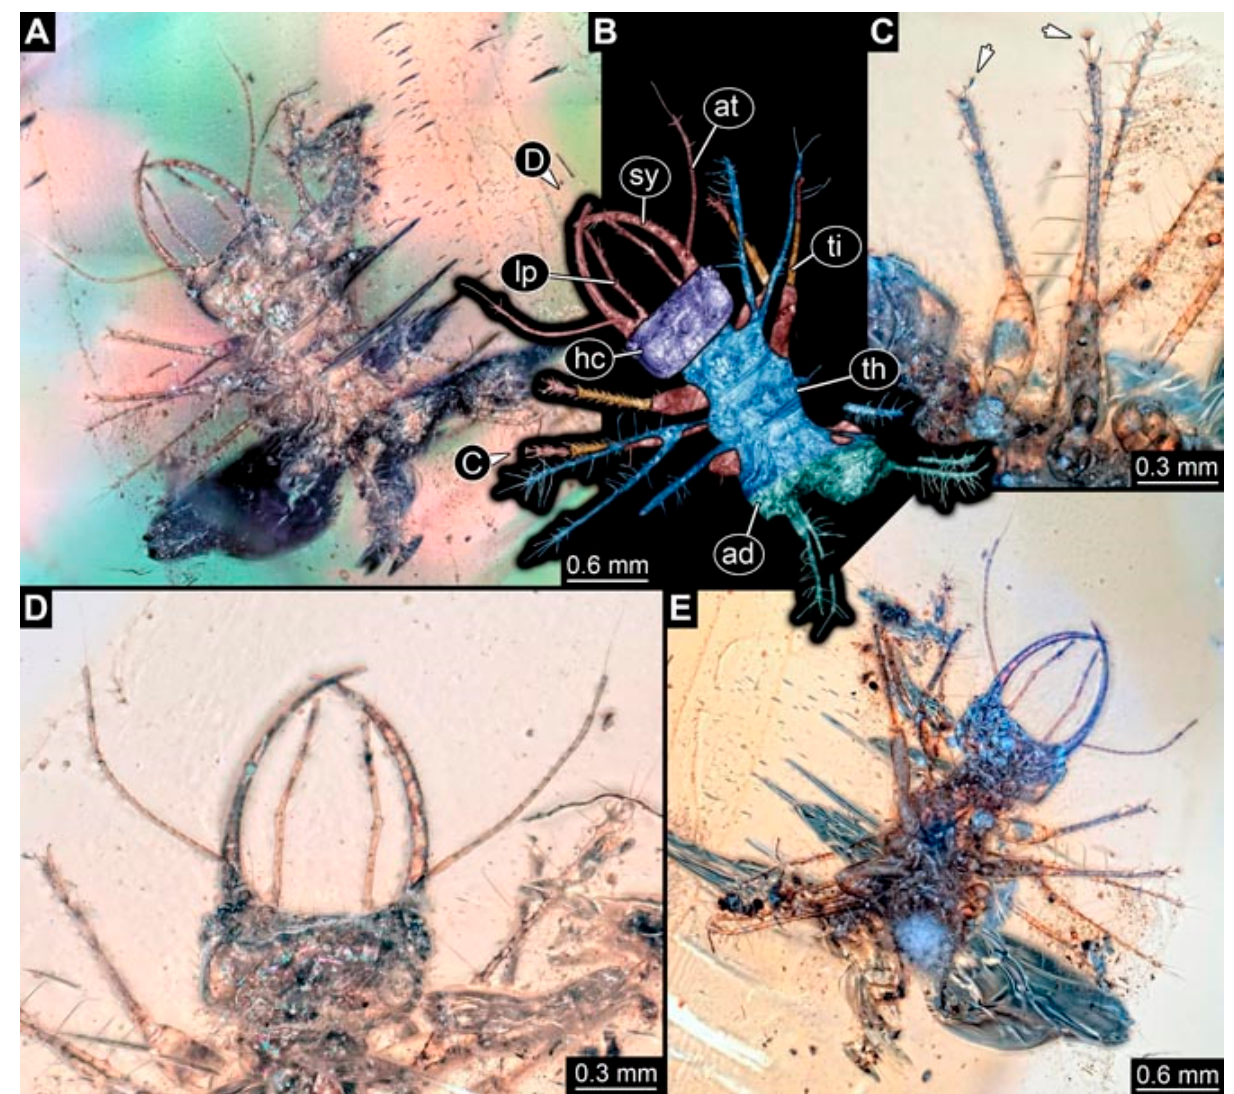
Figure 24. Specimen 4845 (PED 0541); Myanmar amber. ( A ) Ventral view. ( B ) Ventral view, colour- marked. ( C ) Dorsal view. ( D ) Close-up of head capsule in ventral view. Abbreviations: ad = abdo- men; at = antenna; hc = head capsule; lp = labial palp; sy = stylet; th = thorax.